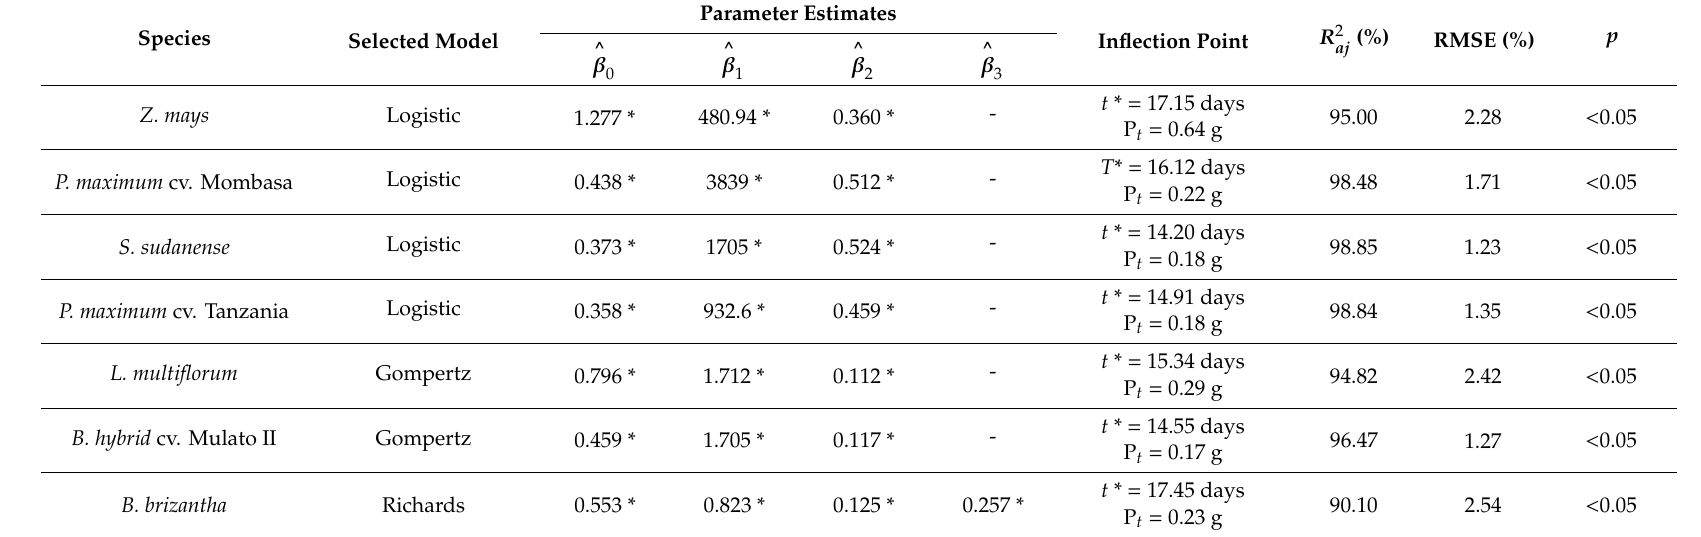
Table 3. S. frugiperda larval weight growth equations on di ff erent